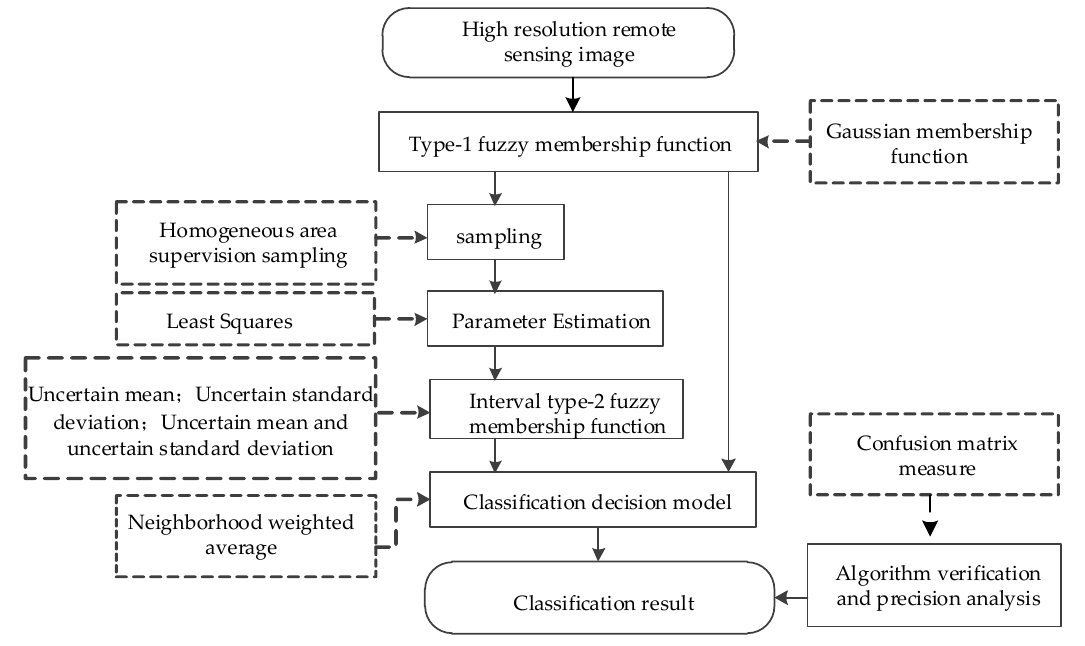
Figure 6. The flowchart of the proposed method.